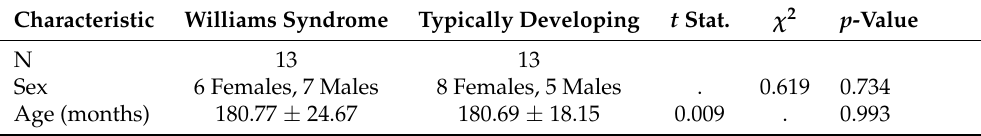
Table 1. Characteristics of the